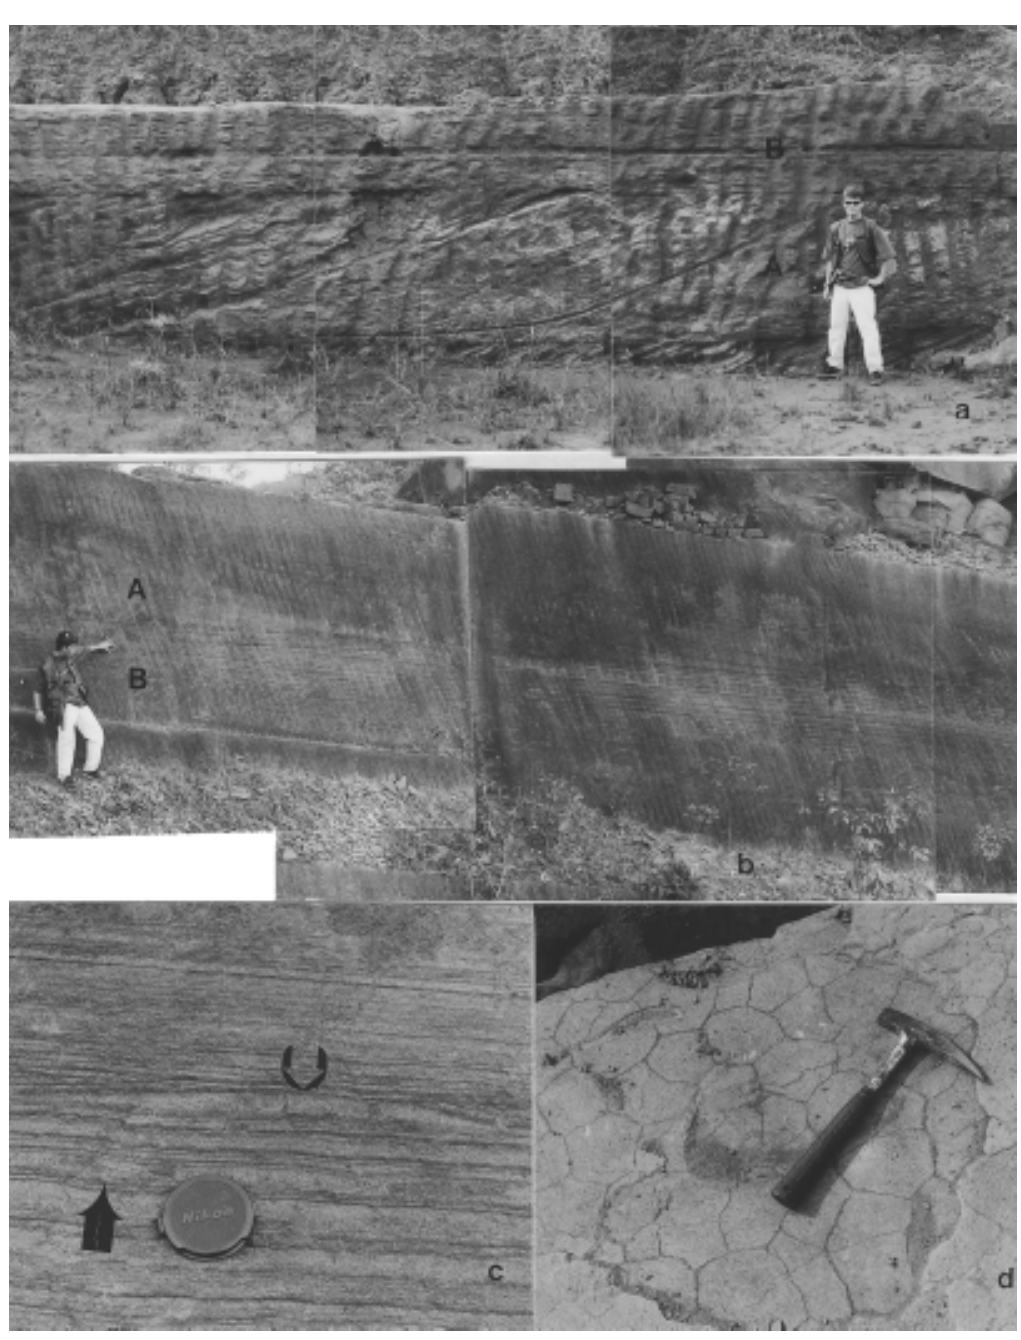
Fig. 3 – a. Upper Portion of Sanga do Cabral Formation, pointing out facies of eolian dunes (A) and dry interdunes (B); b. Eolianities of the informal unit Pedreira Sandstone showing eolian deposits (A) and wet interdune deposits (B); c. Sandstone layers interposed to mudstone in the wet interdunes of Pedreira Sandstone. The dark arrow points to the translatent cross-lamination and the light arrow to the grain flow that hit the interdune; d. Mudcrack casts in the wet interdune deposits of Pedreira Sandstone.